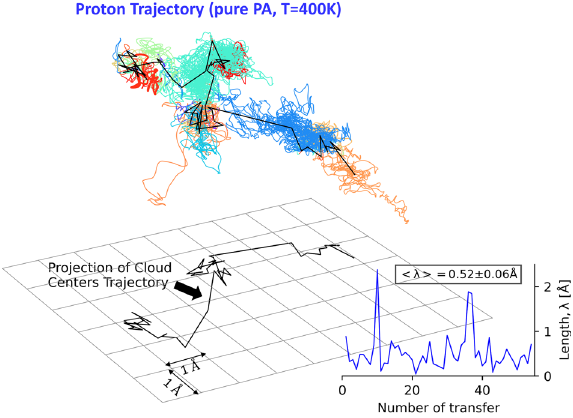
Fig. 8 Trajectory of an individual proton in pure PA. Trajectory lines of an individual proton in pure PA at 400 K. Each colored cloud re fl ects the proton vibrational and rotational motions as the proton is associated with the same oxygen atom. The trajectory changes color when the proton transfers to a different oxygen atom. The center of mass of each cloud is connected by a black line to the center of mass of the next cloud. These black lines present averaged jumps of the proton transfers between the oxygen atoms. (Inset) The length of each proton jump between oxygen atoms (the length of the black lines). The average jump length is very short ~ 0.5 Å, although there are a few larger (~2 Å) jumps that are associated with the large-angle jumps followed by a proton transfer.